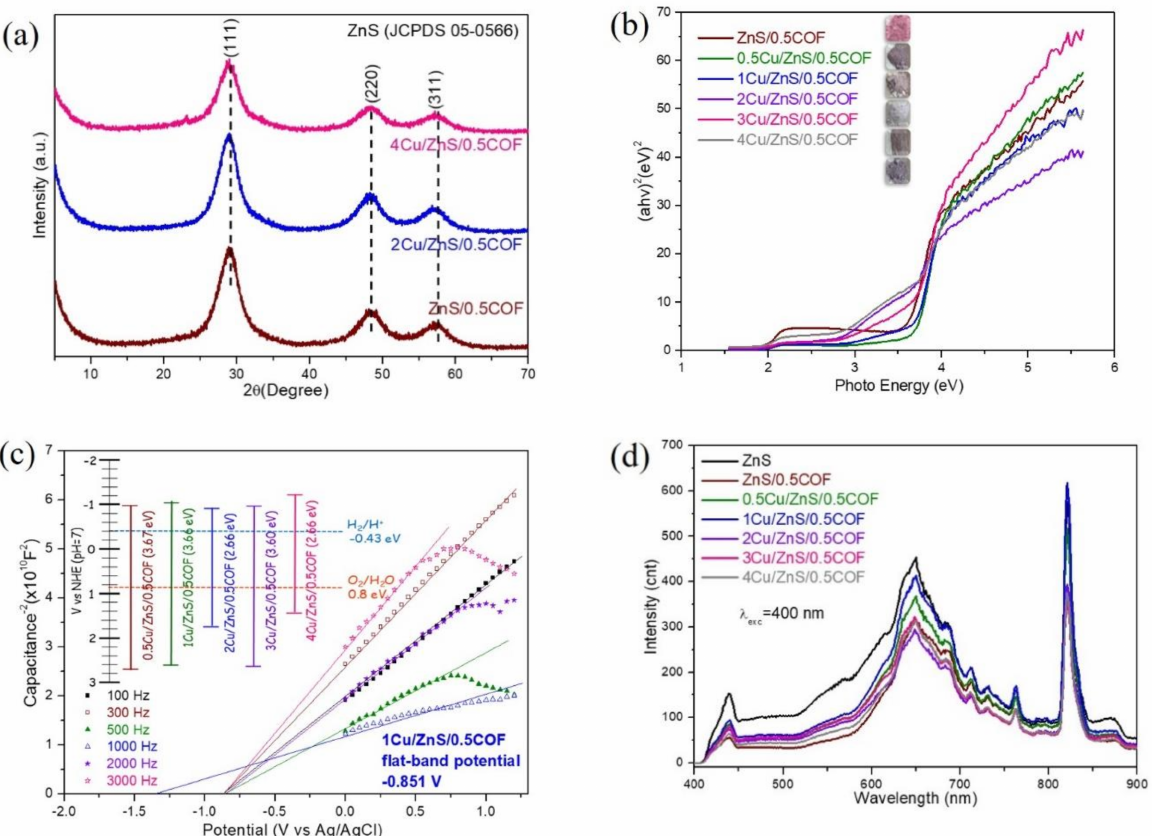
Figure 5. ( a ) XRD patterns, ( b ) UV-Vis spectrum, and ( c ) Mott–Schottky plots, ( d ) PL spectra of Cu/ZnS/COF composite photocatalyst with different Cu